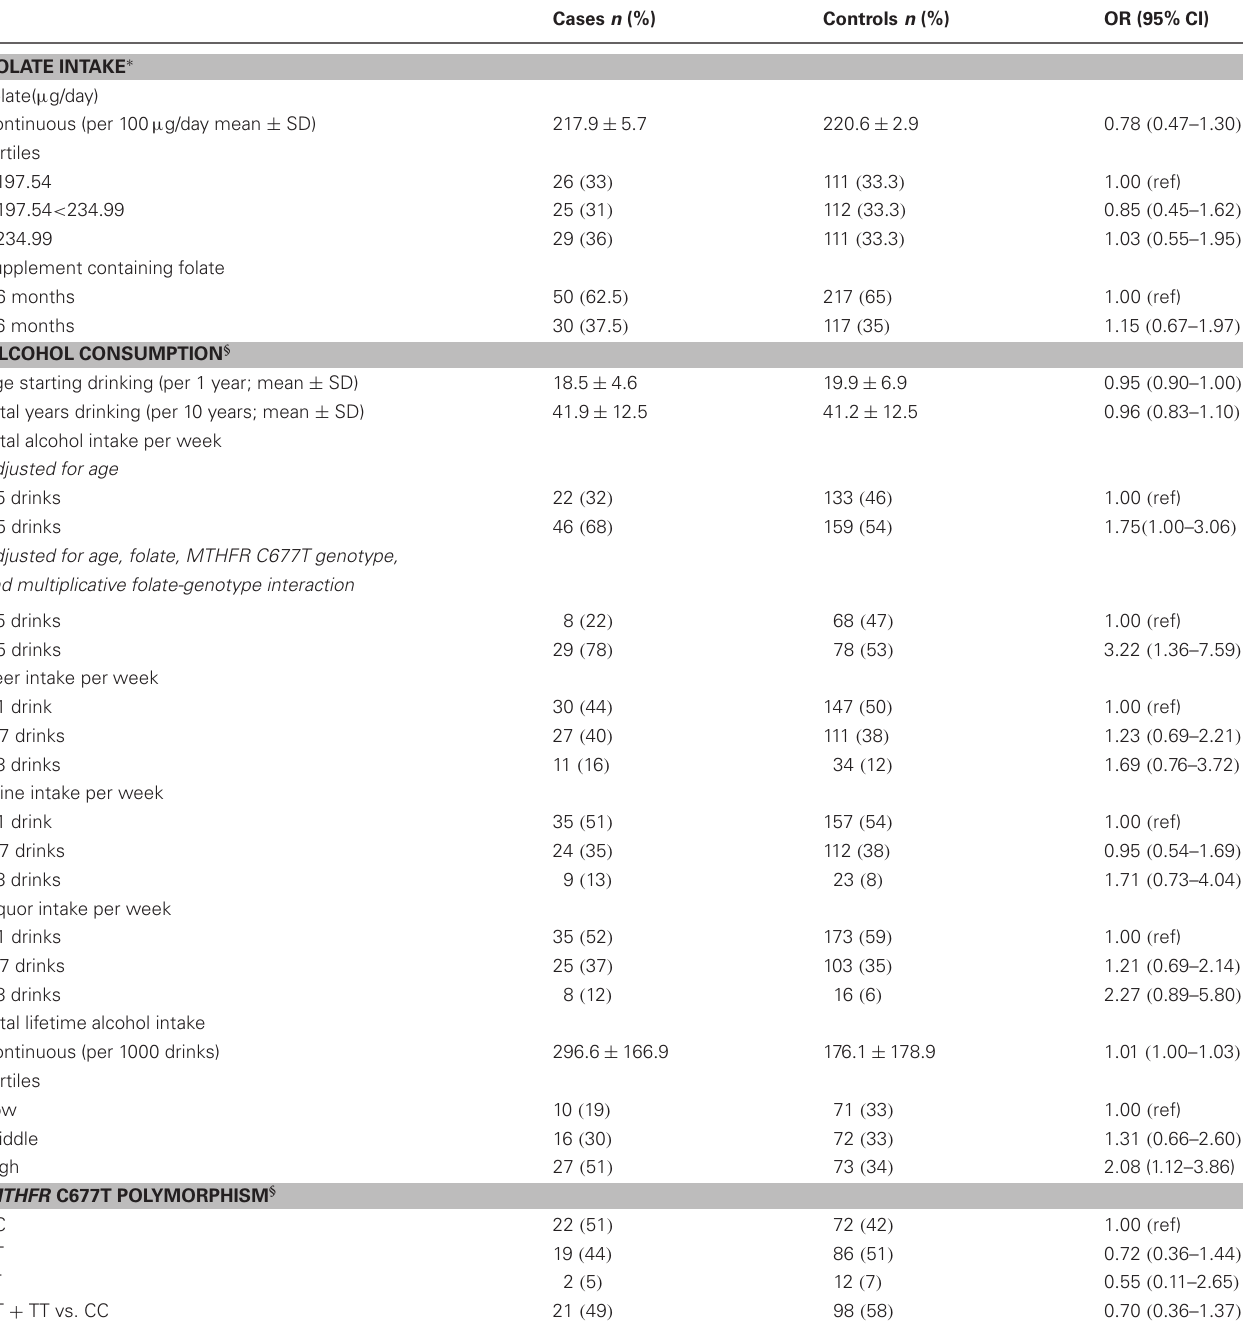
Table 2 | Associations between folate intake, alcohol consumption, the MTHFR C677T polymorphism, and prostate cancer risk, n = 414 (80 cases; 334